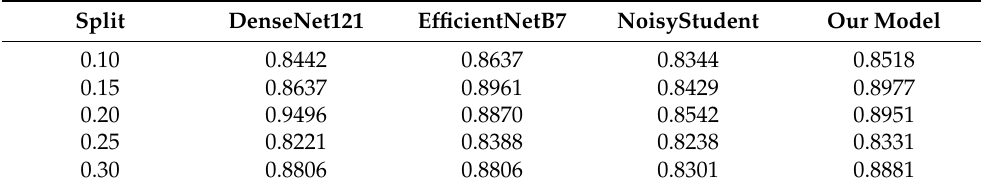
Table 3. Recall of pre-trained models and proposed model at various split ratios. Split